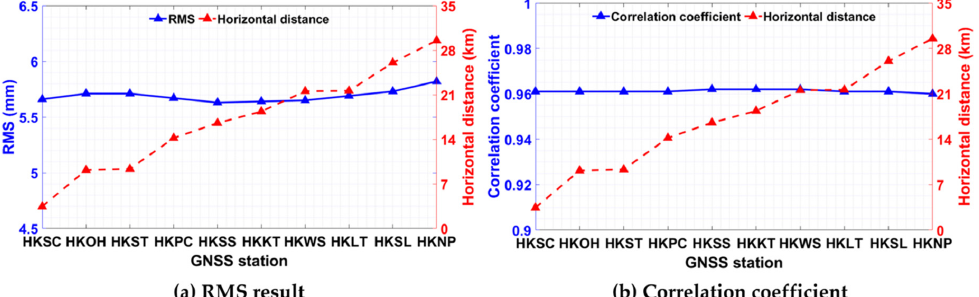
Figure 3. RMS ( a ) and correlation coefficient ( b ) results of calibrated TH-PETs at the KP station using the temperature, pressure, MJD, and ZTD time series (retrieved at ten GNSS stations with different horizontal distances) over the period 2008–2019.